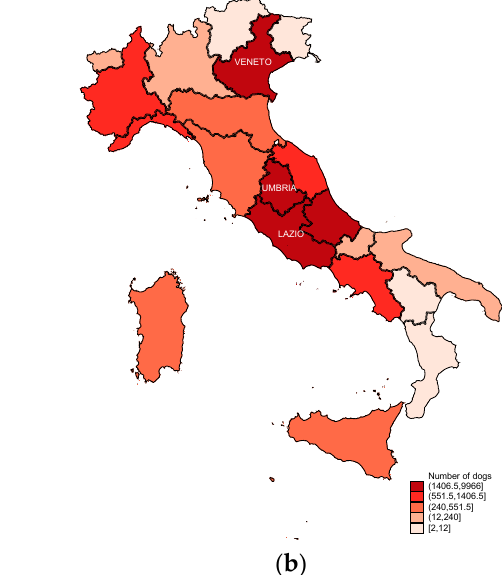
Figure 1. Distribution of dogs with a diagnosis of tumour by sex, neutered/spayed status and age class at first diagnosis. ( a ) Males; ( b ) females. Table 1. Mean age at first diagnosis by sex, neutering status and tumour behavior.